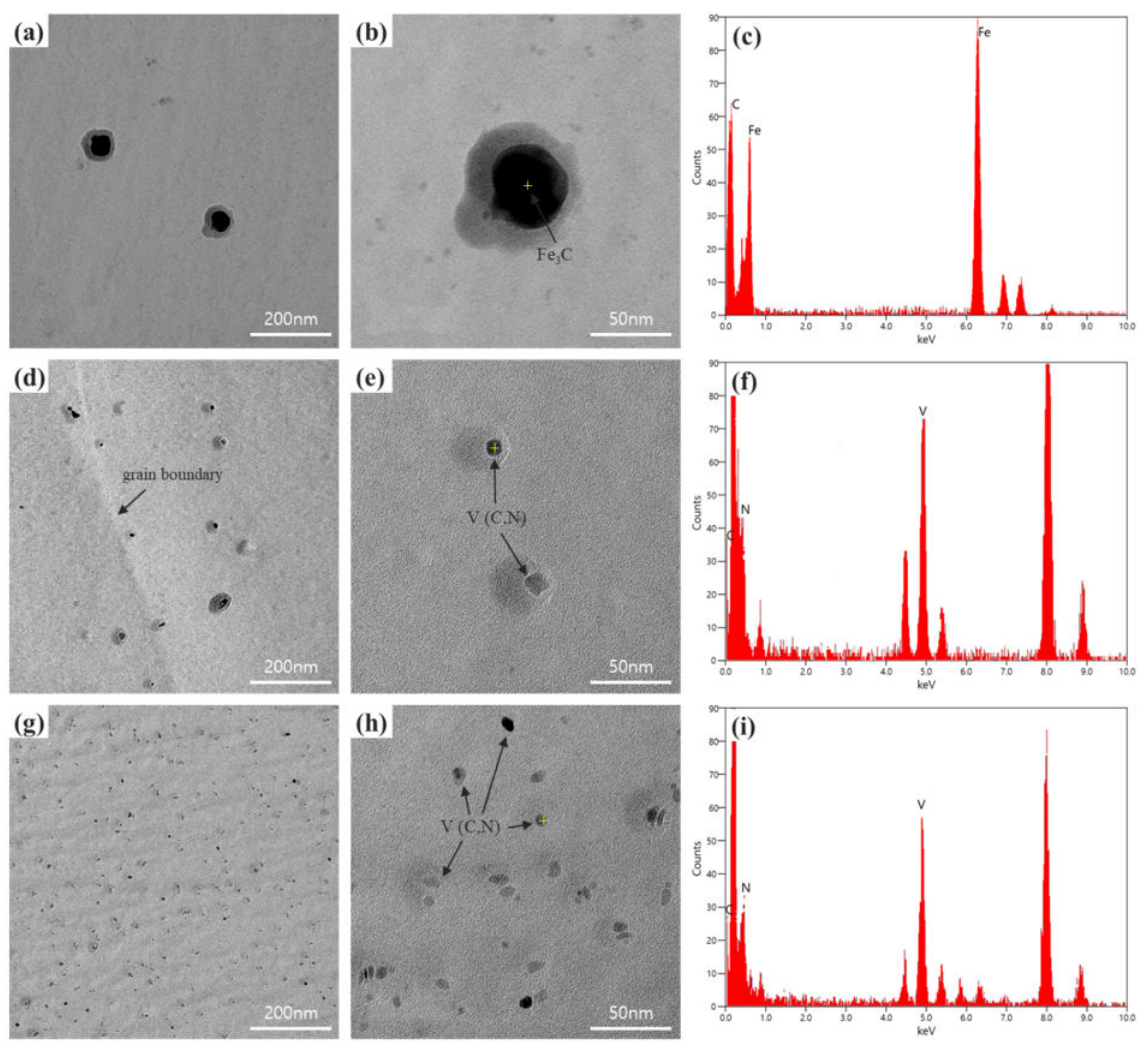
Figure 5. TEM images and EDS analysis of Tempcore rebar specimens showing various precipitates: ( a , b , c ) Fe 3 C for RB V0, ( d , e , f ) V(C, N) for RB V1, and ( g , h , i ) V(C, N) for RB